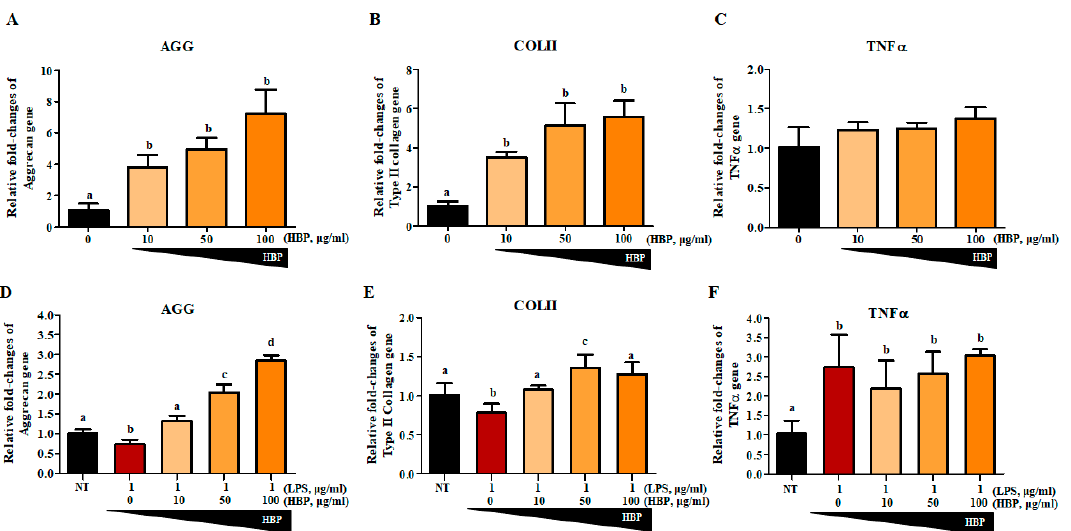
Figure 5. Gene expressions related to chondrocyte potentials with HBP treatment of human cartilage cells. The HBP itself increased ( A ) Aggrecan (AGG), ( B ) Collagen Type II (COLII), and ( C ) TNF α mRNA expressions in NHAC cells in a dose dependent manner ( p < 0.05, n = 3). The LPS-stimulated were treated with various concentrations of HBP, followed by examination of cartilage regeneration-related gene expression. Expression changes in ( D ) AGG, ( E ) COLII and ( F ) TNF α were analyzed via quantitative PCR ( p < 0.05, n = 3). Di ff erent alphabets (a, b, c, and d) in each Figure indicate significant di ff erences among experimental groups ( p <